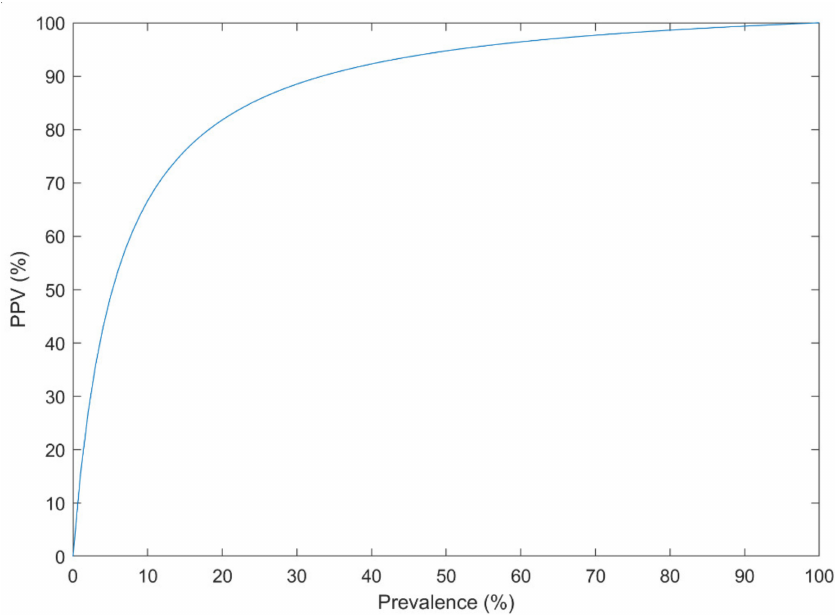
Figure 8. The Positive Predictive Value (PPV) of a diagnosis system with the sensitivity of 90% and specificity of 95% at different disease